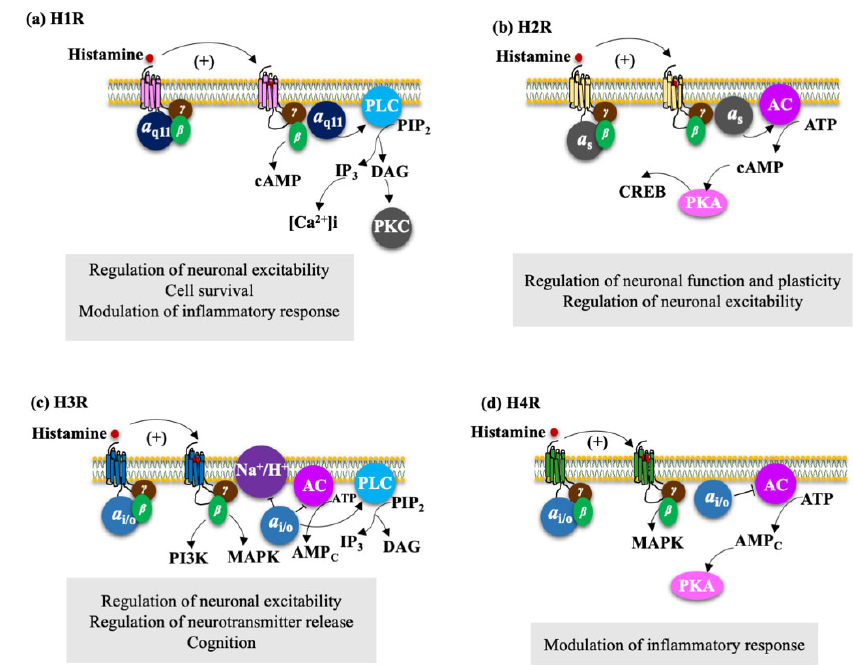
Figure 4. Signaling pathways triggered by histamine receptor activation. Activation of the H1R-H4R receptors, figures ( a – d ). The H1R receptor is widely expressed in the hippocampus, cholinergic and aminergic brain stem nuclei, thalamus, and cortex. H2R is located in the basal ganglia, amygdala, hippocampus, and brain cortex. High H3R densities have been demonstrated in the anterior cerebral cortex, hippocampus, amygdala, striatum, olfactory tubercle, cerebellum, substantia nigra, and brain stem. Finally, expression of H4R mRNA has been reported in the amygdala, cerebellum, corpus callosum, frontal cortex, hippocampus, and thalamus.